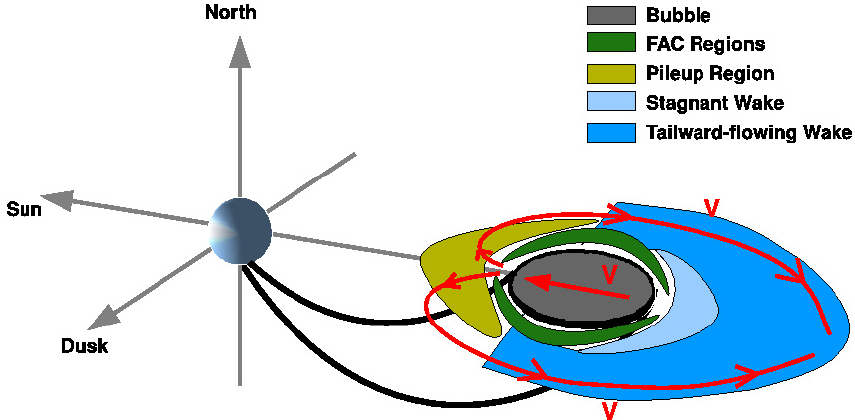
Fig. 15. An illustrated equatorial cut of the morphology of the plasma bubble, as seen by Cluster. The region of flux and plasma pileup in front of the bubble is in yellow, the bubble itself is grey, the stagnant and tailward flowing wakes lighter and darker blues respectively and the field-aligned current regions green. Flow velocity is marked by the red